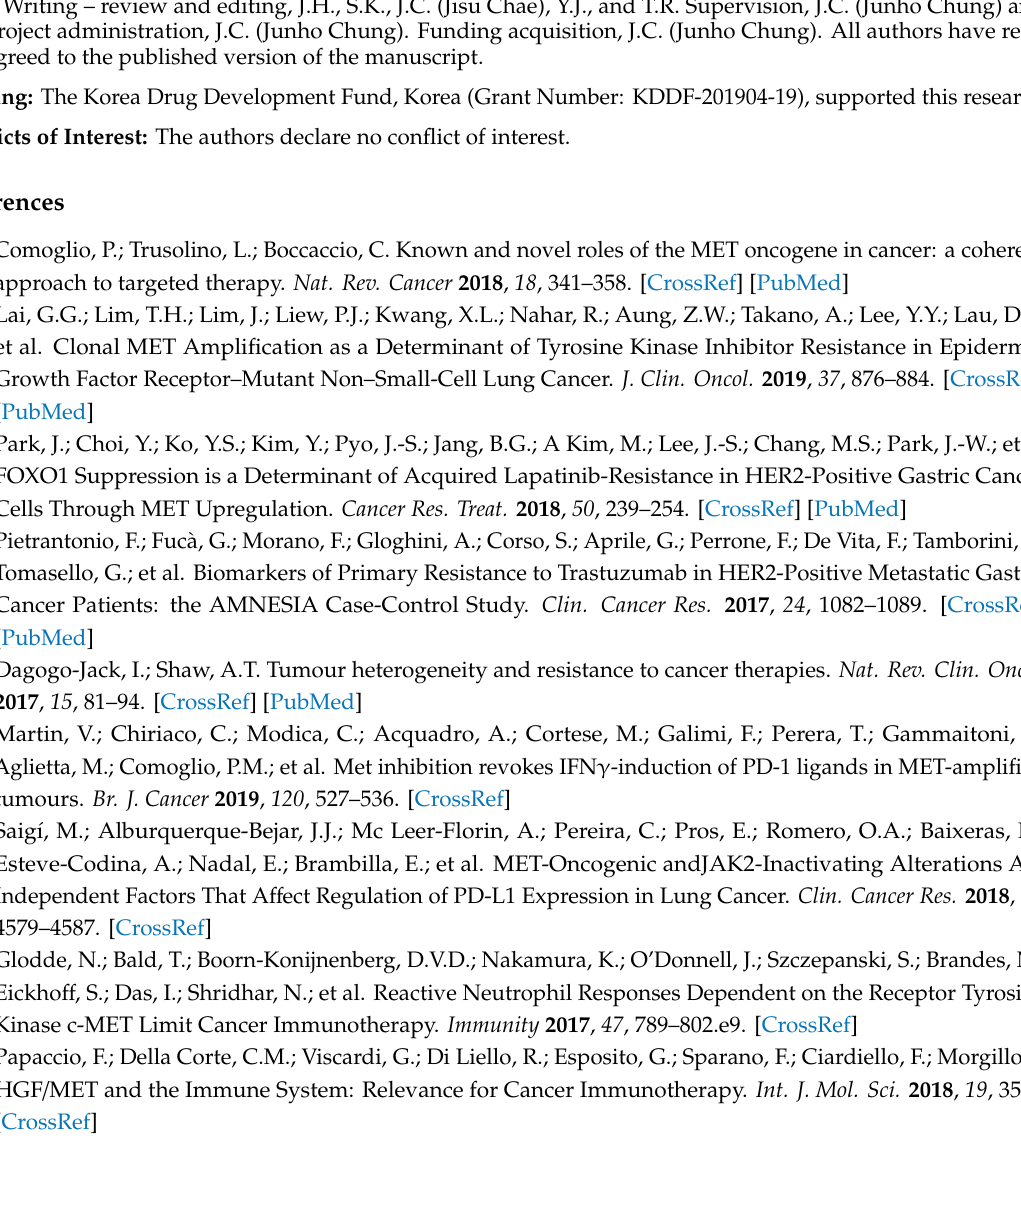
Figure S1: Evaluation of 6 prediction models using training data sets, Figure S2: Shannon’s entropy (SE) change following biopanning procedure, Table S1: Accuracy score distributions of random forest (RF), regularized discriminant analysis (RDA), linear discriminant analysis (LDA), support vector machines (SVM), naïve bayes (NB), AdaBoost Classification Trees (ADA) for HCDR3 binding reactivity predictions, Table S2: Kappa score distributions of RF, RDA, LDA, SVM, NB, and ADA for HCDR3 binding reactivity predictions, Table S3: Accuracy score distributions of RF, RDA, LDA, SVM, NB, and ADA for LCDR3 binding reactivity predictions, Table S4: Kappa score distributions of RF, RDA, LDA, SVM, NB, and ADA for LCDR3 binding reactivity predictions, Table S5: Optimal parameter tuning in generation of random forest model, Table S6: Biopanning titer following four rounds of biopanning, Table S7: Mean-minimal depth of each variables and interaction (HCDR3), Table S8: Mean-minimal depth of each variables and interaction (LCDR3), Table S9: Predicted clones with HCDR3, full variable domain sequences with prediction results and confidence value, Table S10: Predicted clones with LCDR3, full variable domain sequences with prediction results and confidence